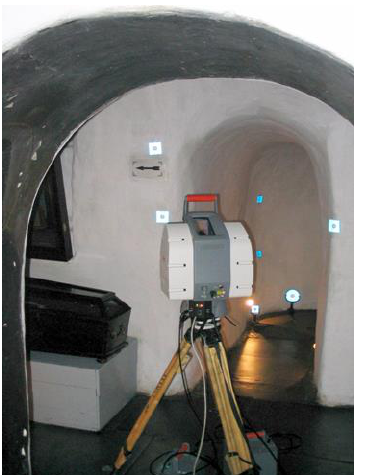
Fig. 6. Leica ScanStation and different orientation targets